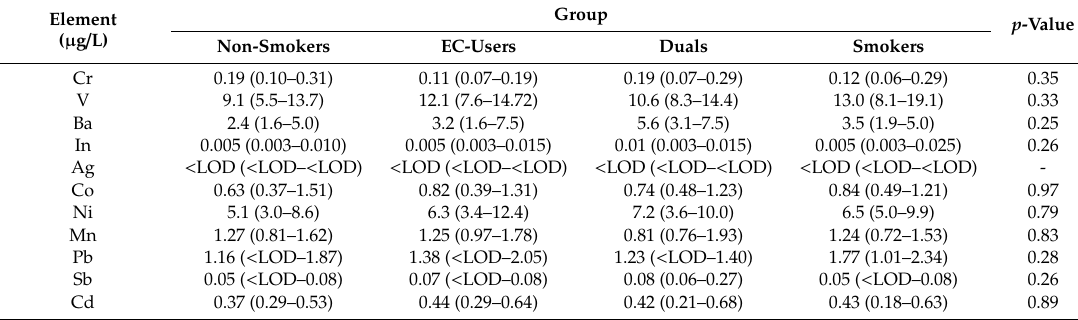
Table 2. Median (interquartile range) of urinary element concentration in particular